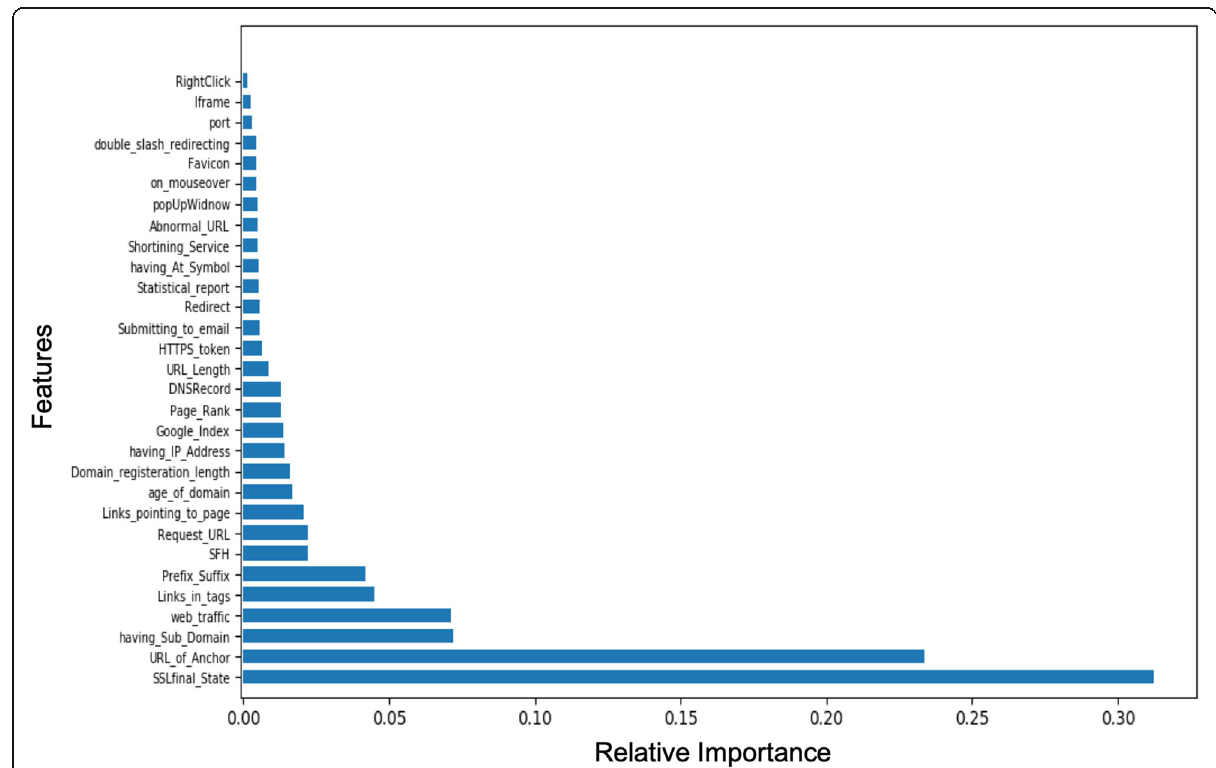
Fig. 5 Model-based feature importance of 30